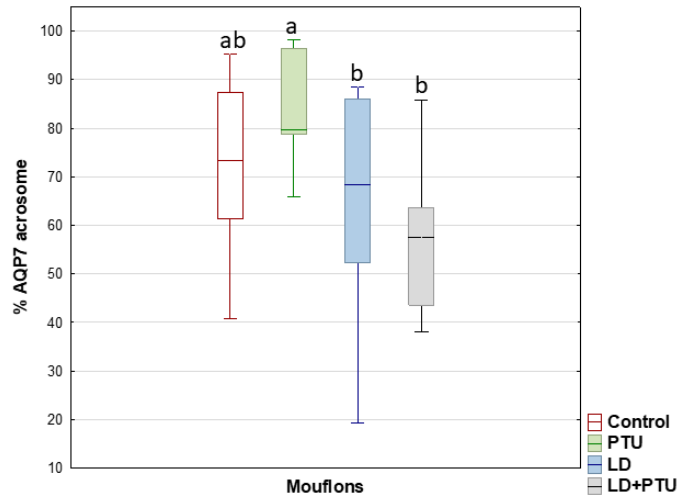
Figure 9. AQP7 expression by immunocytochemistry labelling (ICC) in acrosome of mouflon sperm (controls (red); administered propylthiouracil (PTU, green), exposed to long day photoperiod (LD, blue), exposed to long day photoperiod plus PTU (LD+PTU, gray)). The boxes spread form the 1st to the 3rd quartiles. Box plots show the median (horizontal line) and spread from the 1st to the 3rd quartiles; the whiskers extend from the smallest to the largest value. Different letters (a,b) between boxplots indicate significant differences (PTU vs. LD, p = 0.05; PTU vs. LD+PTU, p =